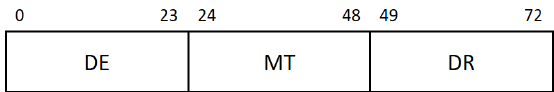
Figure 4. Solution representation of GA in case study 1.